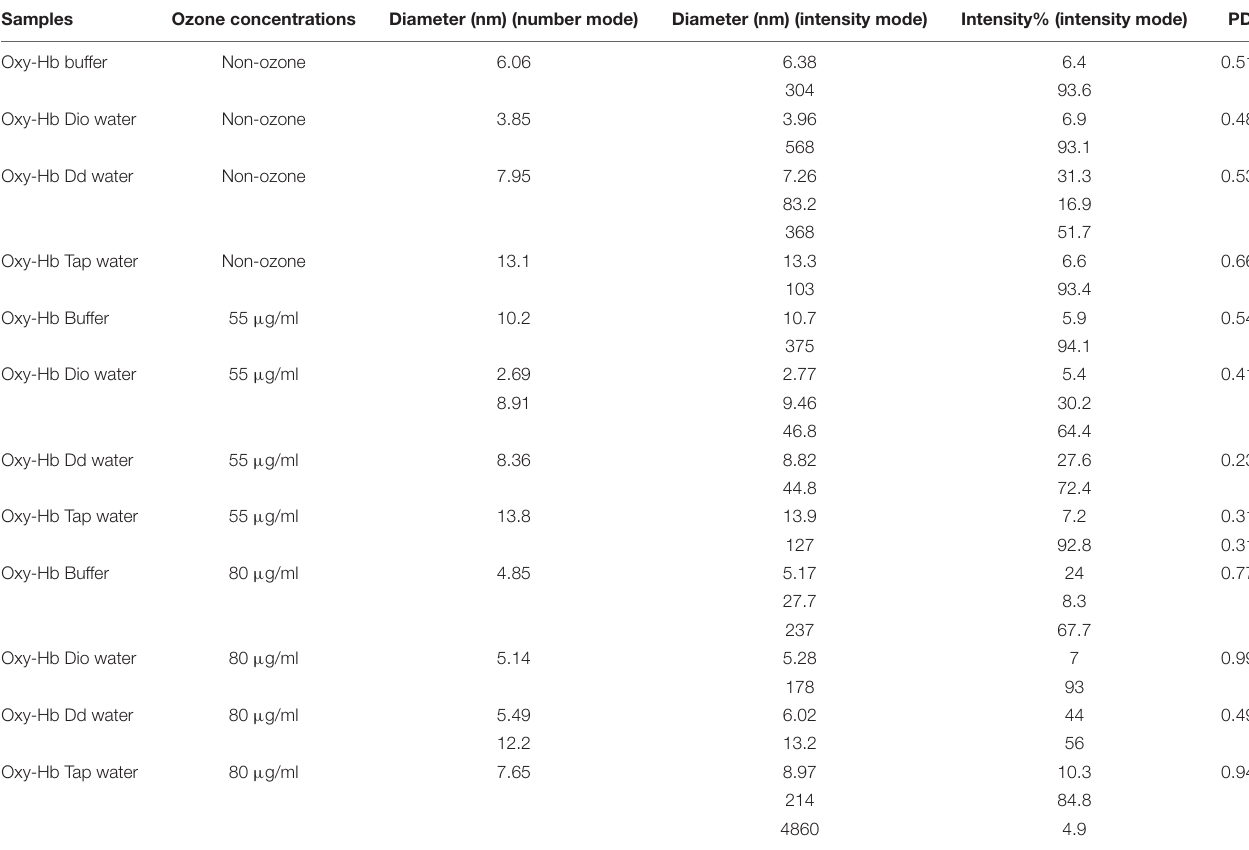
TABLE 3 | Size distribution analysis of Hb samples in number and intensity modes as well as percentage intensity and PDI values using DLS. Dio and Dd water refer to deionized and double distilled water, respectively.